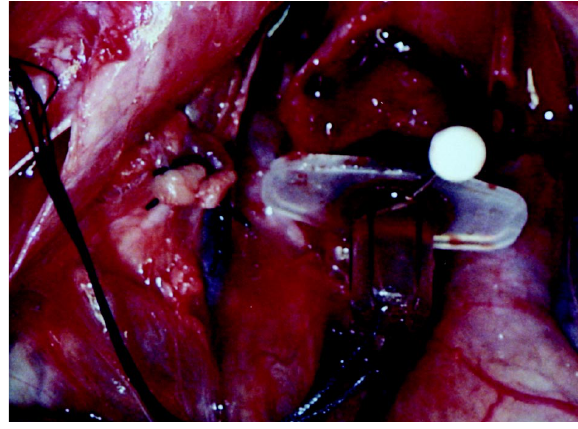
Figure 4 – Device correctly inserted.